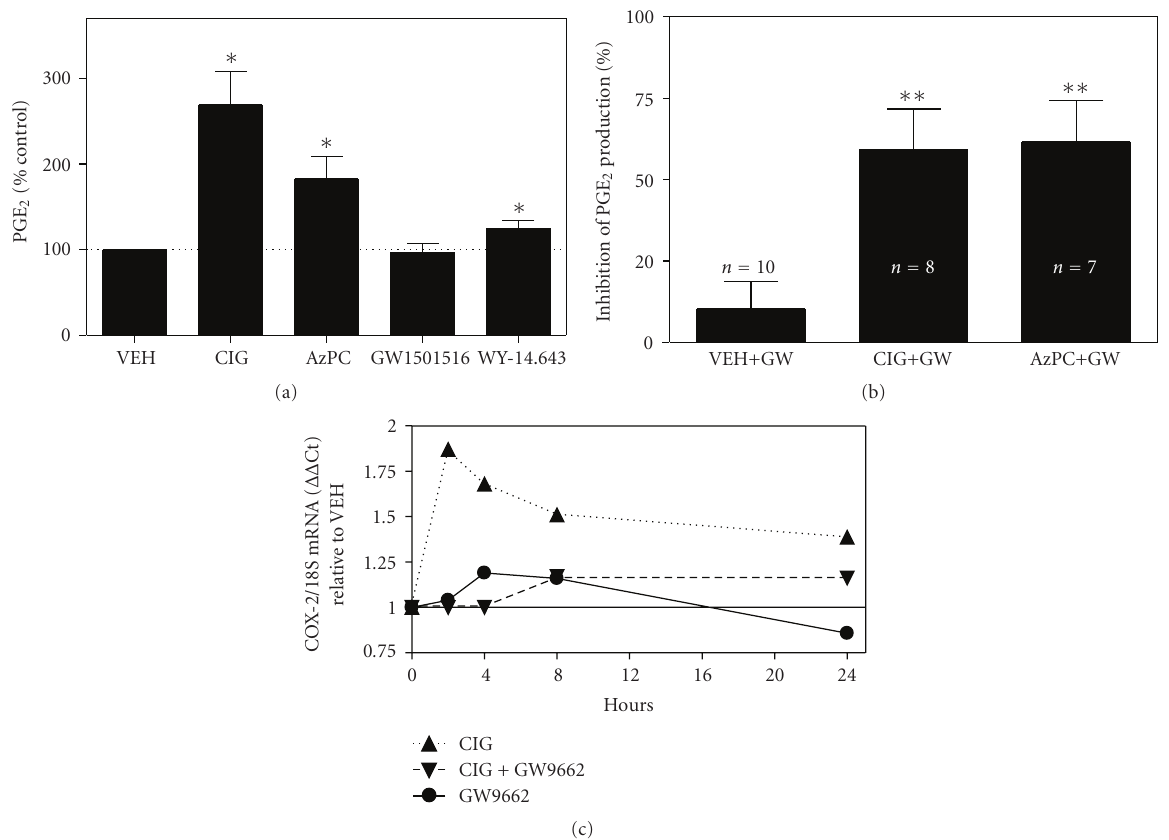
Figure 2: PPAR γ agonists, but not PPAR α or β/δ agonists, induce PGE 2 production in PHKs; PPAR γ agonist-induced PGE 2 production and COX-2 mRNA expression are inhibited by GW9662. (a) PPAR γ agonists, but not PPAR α or β/δ agonists, induce PGE 2 production in PHKs. PHKs were treated for 24 hours with vehicle (CONT), 5 μ M of the PPAR γ agonist, ciglitazone (CIG), 1 μ M of the endogenous PPAR γ agonist, azPC, a PPAR α agonist (WY-14,643, 1 μ M), or a PPAR β/δ agonist (GW501516, 500 nM). The media were then removed and PGE 2 was quantitated in the culture media using a commercial PGE 2 EIA kit. Values represent the mean ± SEM of PGE 2 levels as a percent of control levels ( N = 5 experiments done in triplicate). ∗ P < . 05, one sample t -test . (b) GW9662 inhibits PPAR γ agonist-induced PGE 2 production in PHKs but has no significant e ff ect on vehicle-treated cells. PHKs were pretreated for 1 hour with 1 μ M GW9662 prior to addition of vehicle (VEH), ciglitazone (5 μ M), or azPC (1 μ M) for 24 hours. PGE 2 was then quantitated in tissue culture supernatants. The results shown represent the percent inhibition of vehicle or agonist-induced PGE 2 formation by GW9662. Mean and SEM . ∗∗ P < . 01, one- sample t -test. (c) GW9662 treatment inhibits ciglitazone-induced COX-2 mRNA expression. PHKs were treated with vehicle and ciglitazone, with and without GW9662, as detailed in Figure 2(b) above. At 2, 4, 8, and 24 hours, total RNA was isolated and quantitative RT-PCR was performed for COX-2 mRNA and 18S rRNA expression. The results are shown as COX-2 expression normalized to 18S and expressed as a fold change relative to VEH control (assigned a value of 1 for all time points). When data for all time points was analyzed, only ciglitazone- treated cells exhibited a significant induction in COX-2 expression (one-sample t -test, P = . 0101).